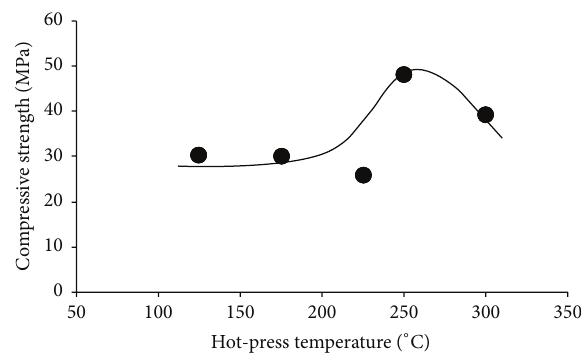
Figure5:EffectofthemassfractionGS/(GL+GS)onthecomposite compressive strength. The total mass of (GL + GS) was retained at 9g. The other parameters used were as follows: 1.5 g paper, 1.5 g plastic, 1g cloth, 3 g PVAc, 13mL water, and a hot-press temperature of 250 ∘